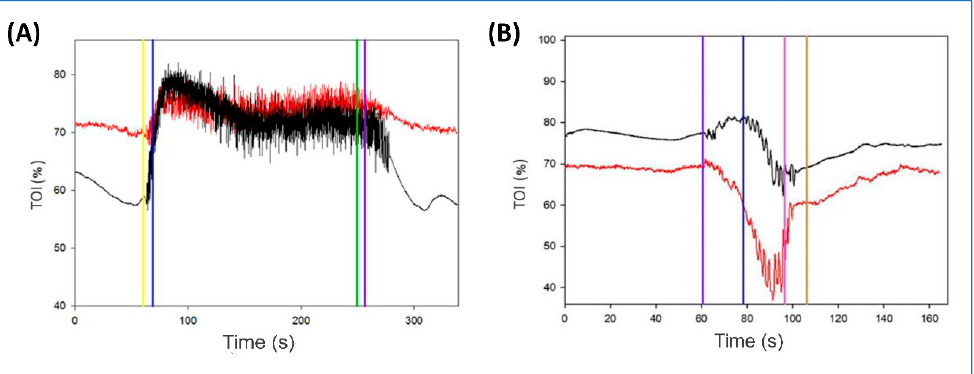
Figure 4. Representative example of the tissue oxygenation index (TOI, %), measured on the right (wiNIREM, red line) and the left (PortaMon, black line) rectus femoris during a 10-km/h running ( A ), where yellow vertical line: incremental; light blue: start; green: stop; violet: recovery, and dynamic high squat ( B ), where violet vertical line: positioning; light blue: start; pink: stop; orange: recovery. For the details see the “Material and Methods” section.